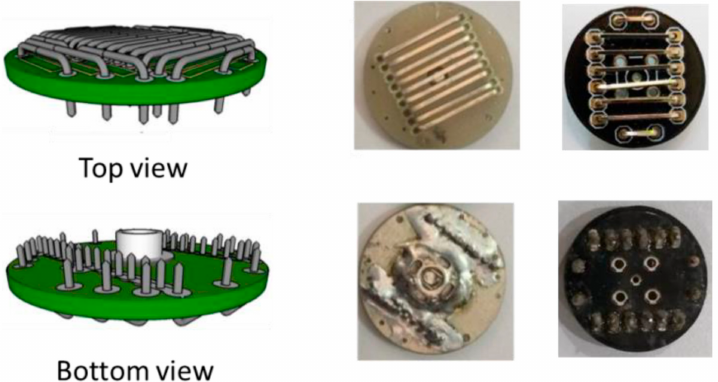
Figure 7. Electrode design ( left panel) and implementation ( right panel). From [126], originally published under a CC-BY